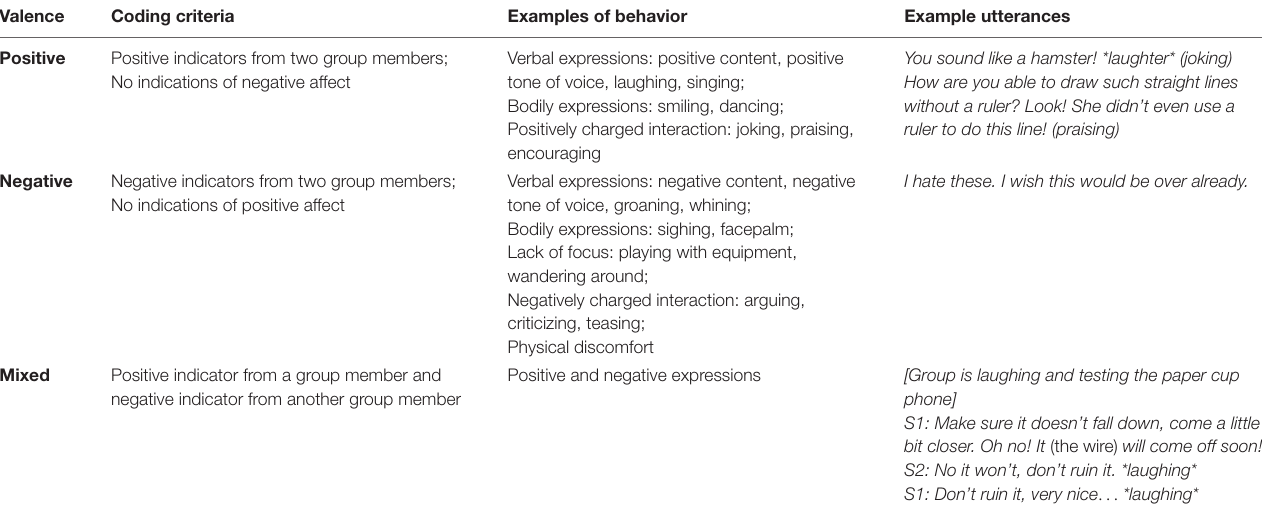
FIGURE 1 | Multistep video-coding procedure starting with the coding of group-level socio-emotional interactions with different emotional valences (steps 1 and 2) followed by identifying each individual group member’s participation in those interactions with different valences (steps 3 and 4) and, finally, the combination of the video coding of students’ participation in socio-emotional interactions with students’ emotional activation as determined from the EDA data. TABLE 1 | Video coding examples of group socio-emotional interactions with different valences (Törmänen et al., 2022). Valence Coding criteria Examples of behavior Example